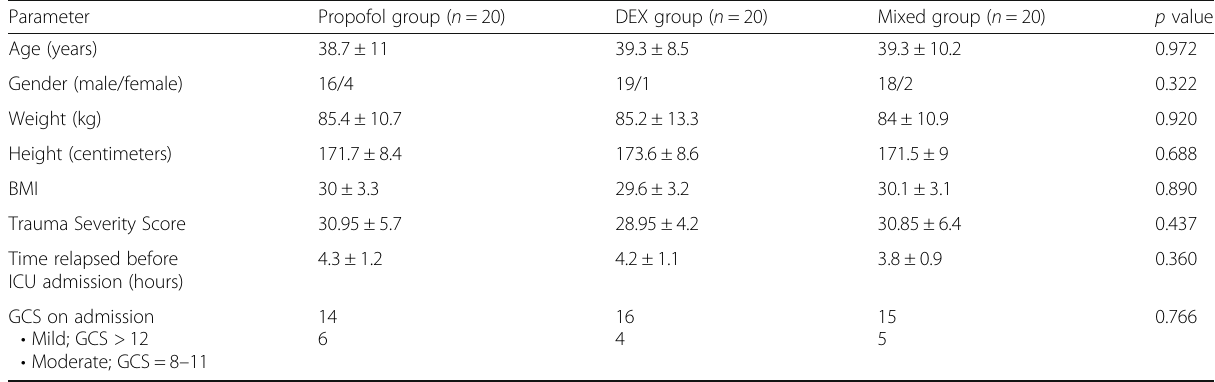
Table 1 Patient